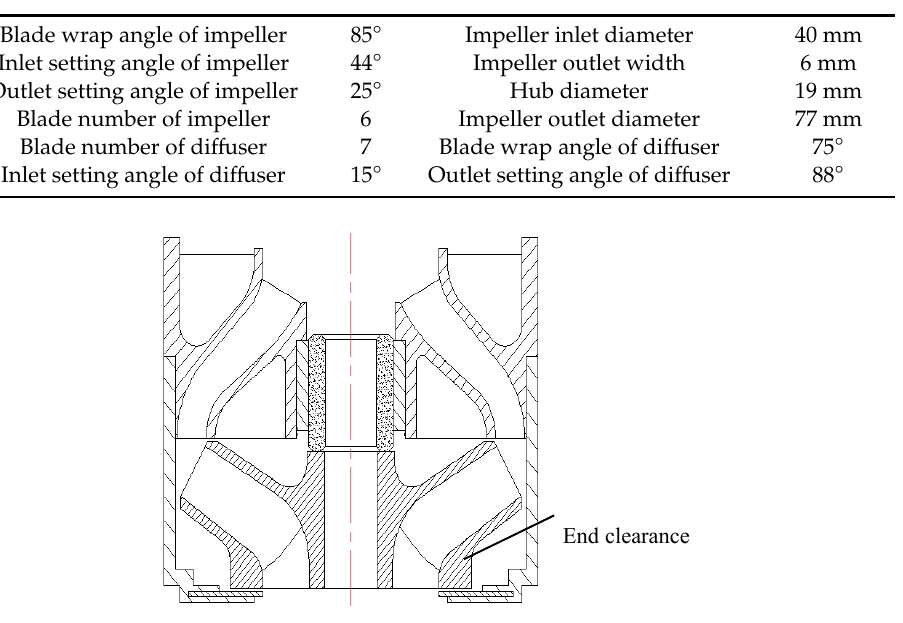
Table 1. Parameters of impeller and diffuser.